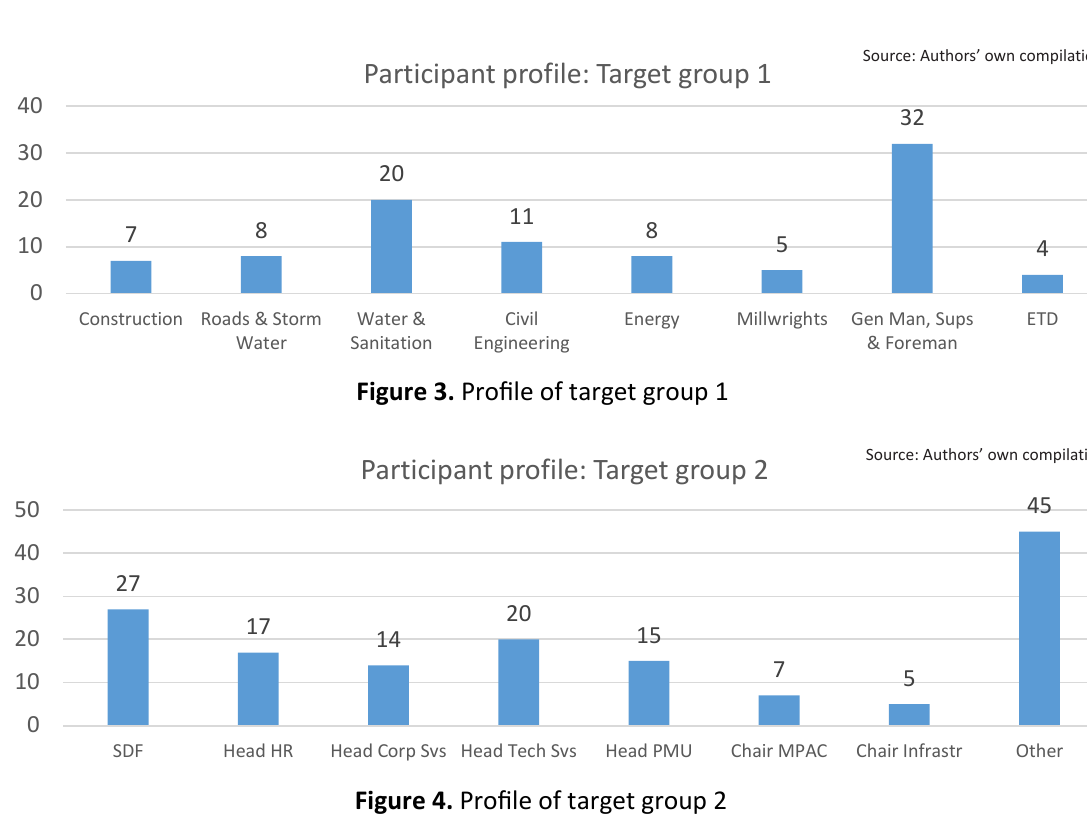
Figure 4. Profile of target group 2